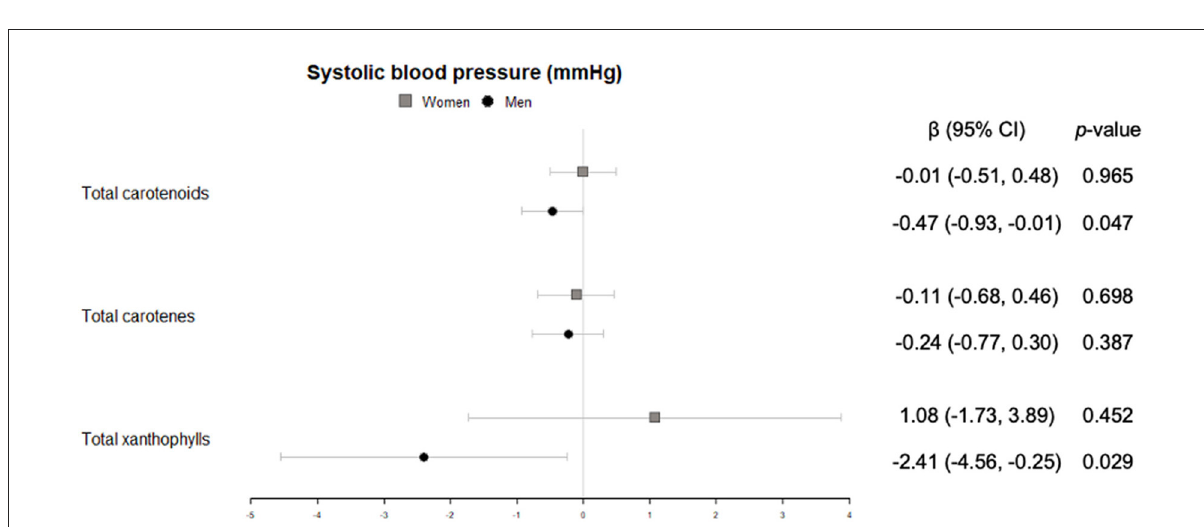
FIGURE4 Cross-sectional association of plasma carotenoids and subclasses (per unit increase) with systolic blood pressure (mmHg) (95%-CI), and their respective p -values.